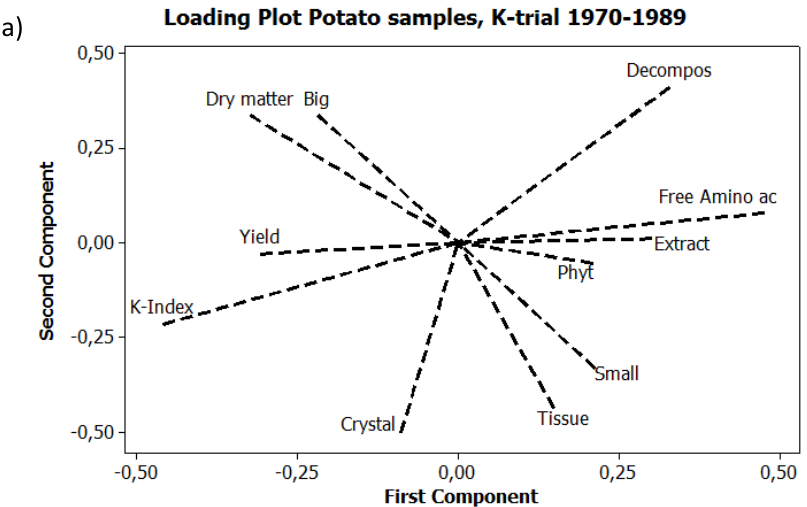
Figure 3. PCA plots on annual, mean values of potato samples in the UJ-trial 1971–1976. ( a ) Loading plot on 22 different variables; ( b ) Score plot expressing the variation among different treatments and seasons. Cultivar